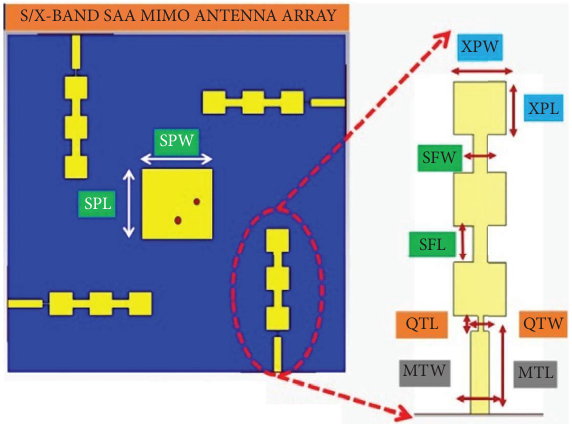
Figure 4: Geometry of X-band port element. Table 2: Dimensions of the antenna design prototype of the linear array antenna.